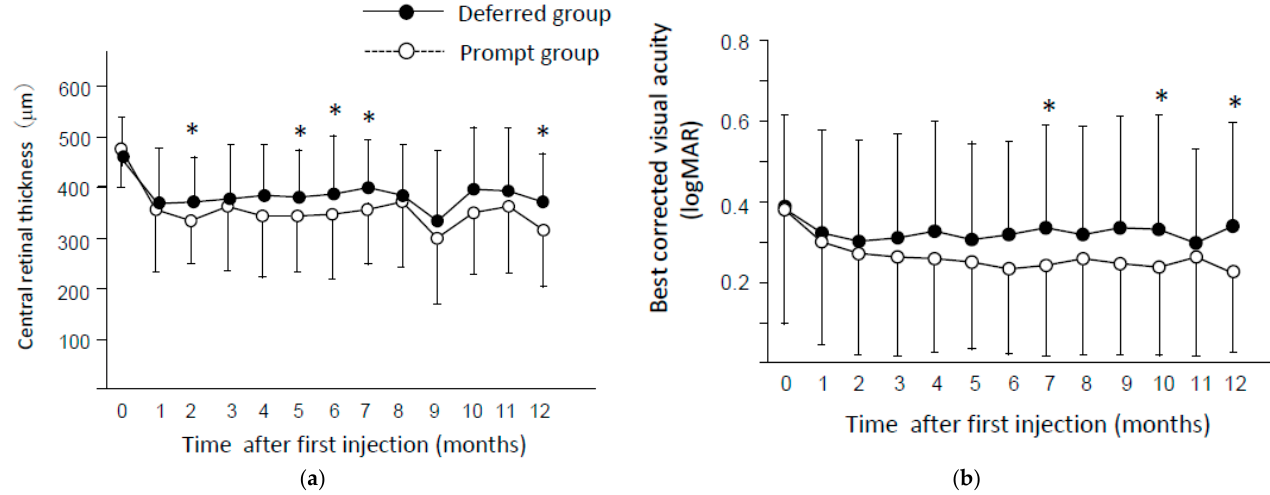
Figure 3. Change in ( a ) central retinal thickness (CRT) and ( b ) best corrected visual acuity (BCVA) in the prompt group and deferred group. * p < 0.05 (prompt group vs. deferred group). Data are presented as the mean ± standard deviations (SDs). BCVA is expressed as logMAR.